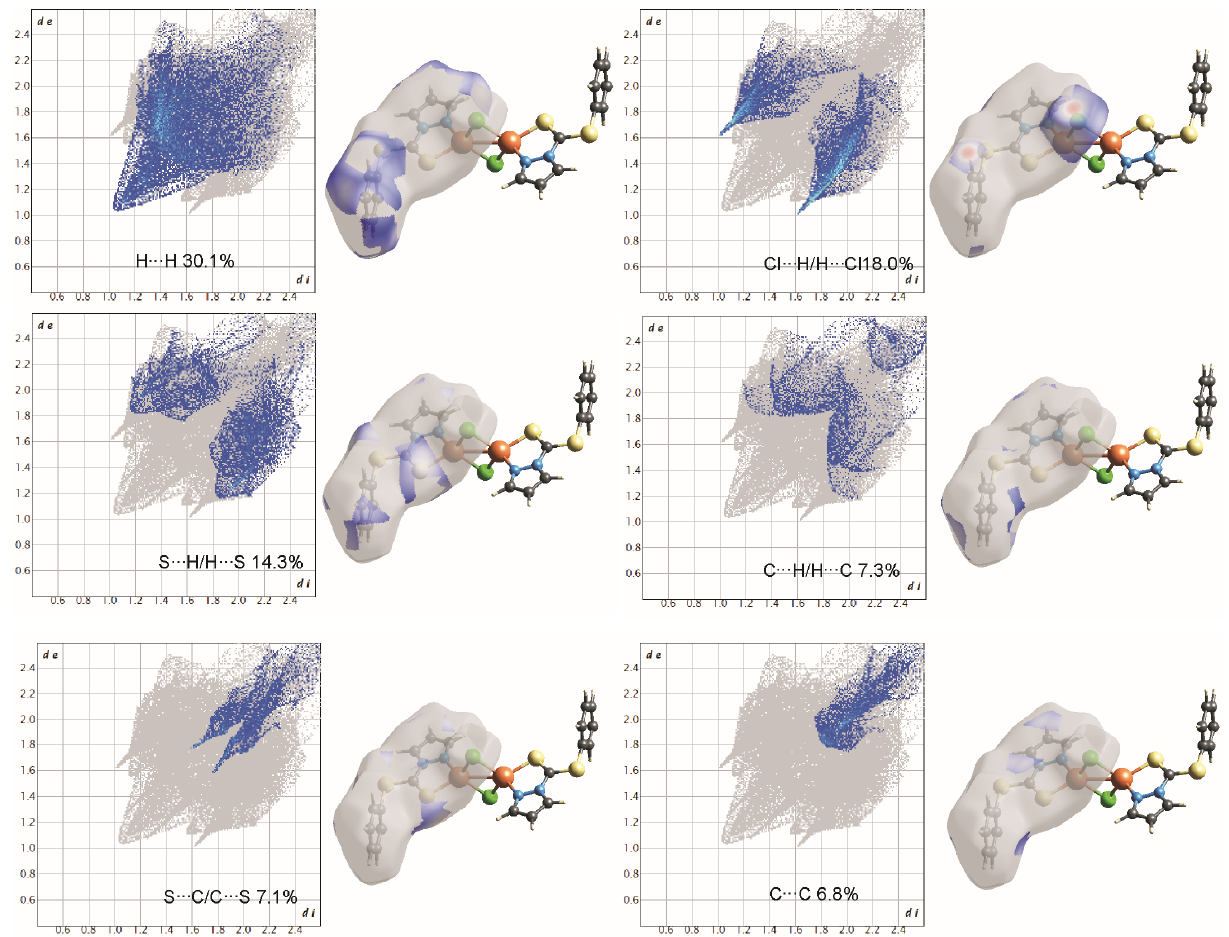
Figure 7. Two-dimensional fingerprint plots of complex 1 , all intermolecular contacts are included. The percentage contribution for each contact is specified at the lower part of each subfigure.